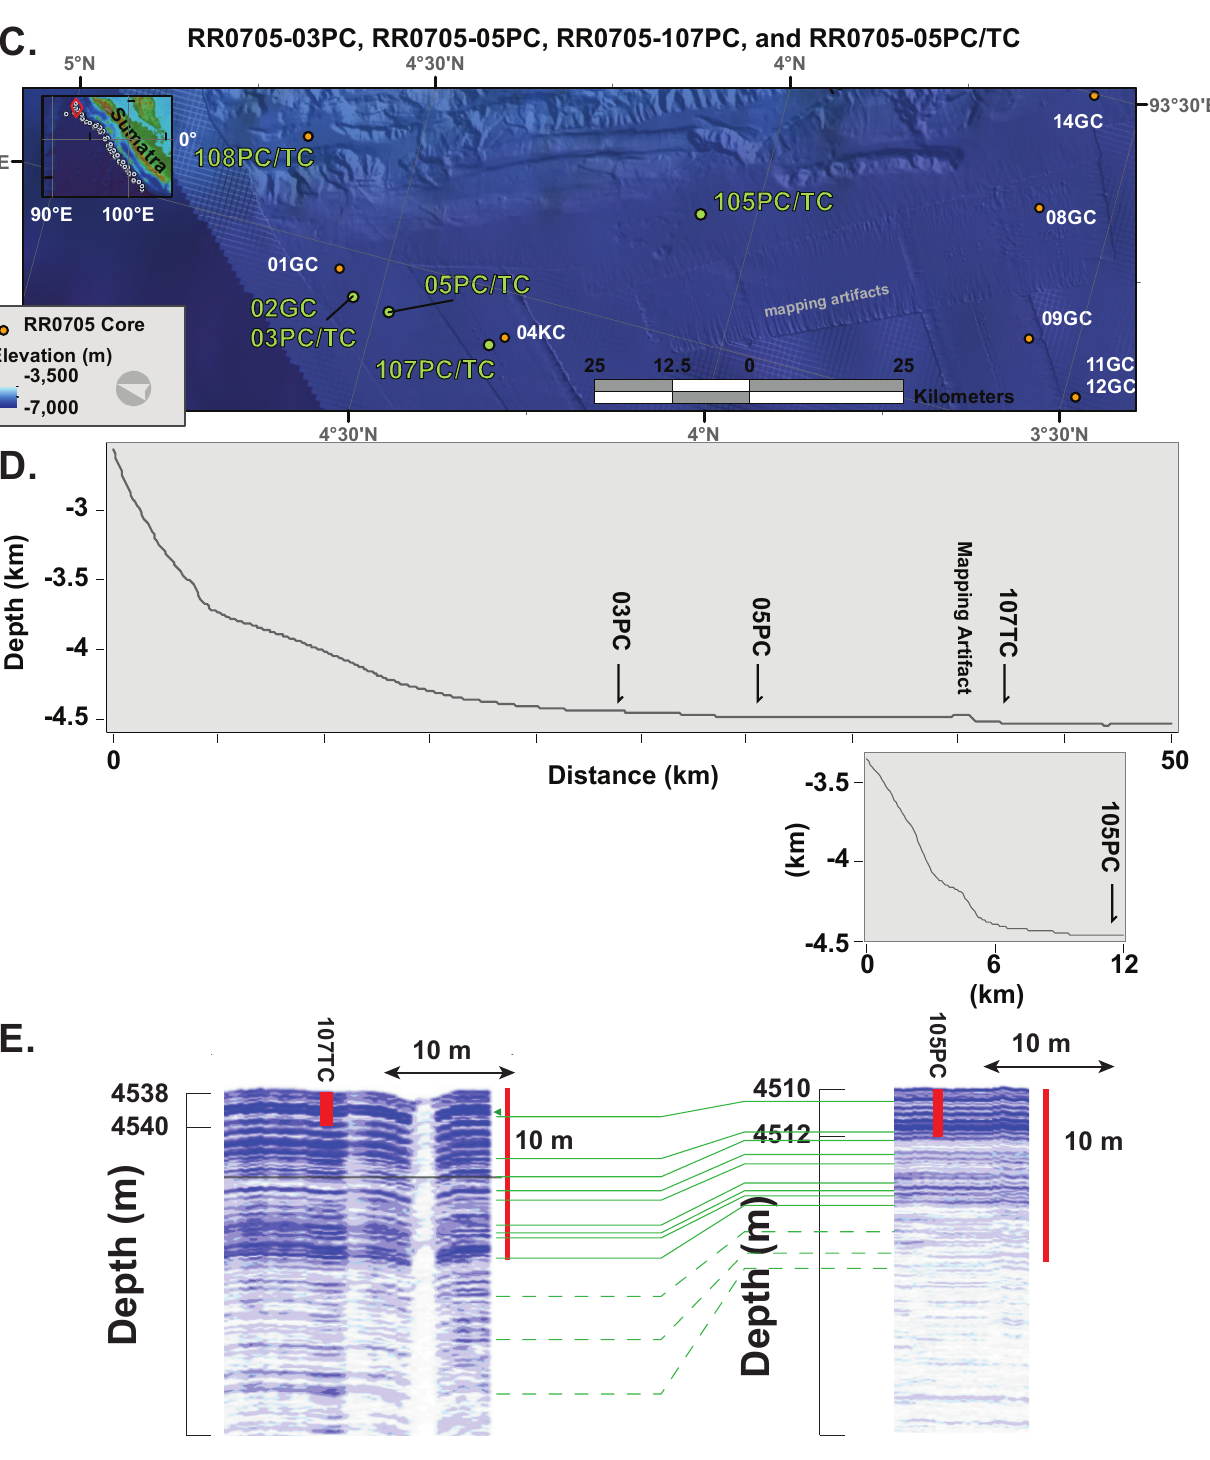
Fig. 8. (C) Map showing core locations. (D) Flow pathway profiles as shown in (B) are plotted with elevation versus distance. Core locations are labeled. (E) 3.5kHz CHIRP seismic data collected at core sites are processed in SioSeis and plotted in SeiSee (seismic envelope). Acoustically opaque sediments are marked by a green arrow. Core locations are designated by a red line scaled to core length. The profile is smaller than the dot that designates the core location in (B)